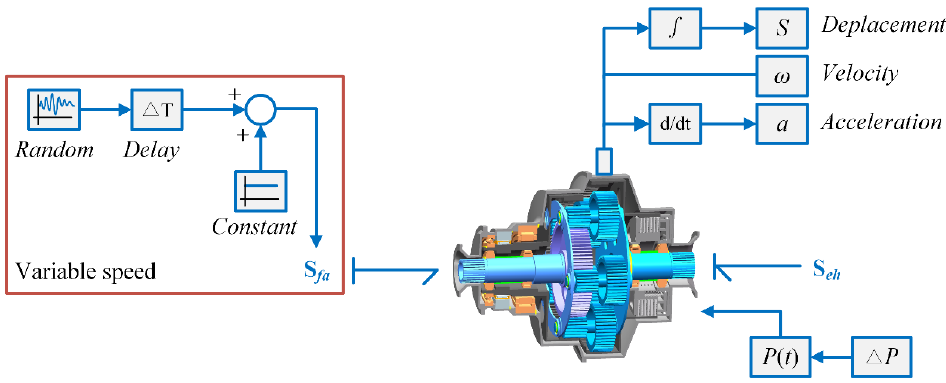
Figure 13. Dynamic design scheme of the transmission system based on the uncBG model.